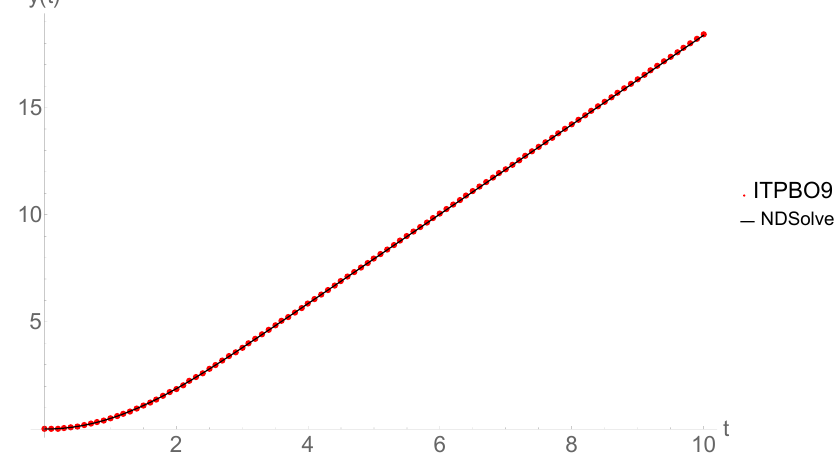
Figure 4. Response curve concerning Equation (29) with h = 0.1 in t ∈ [ 0,10 ]